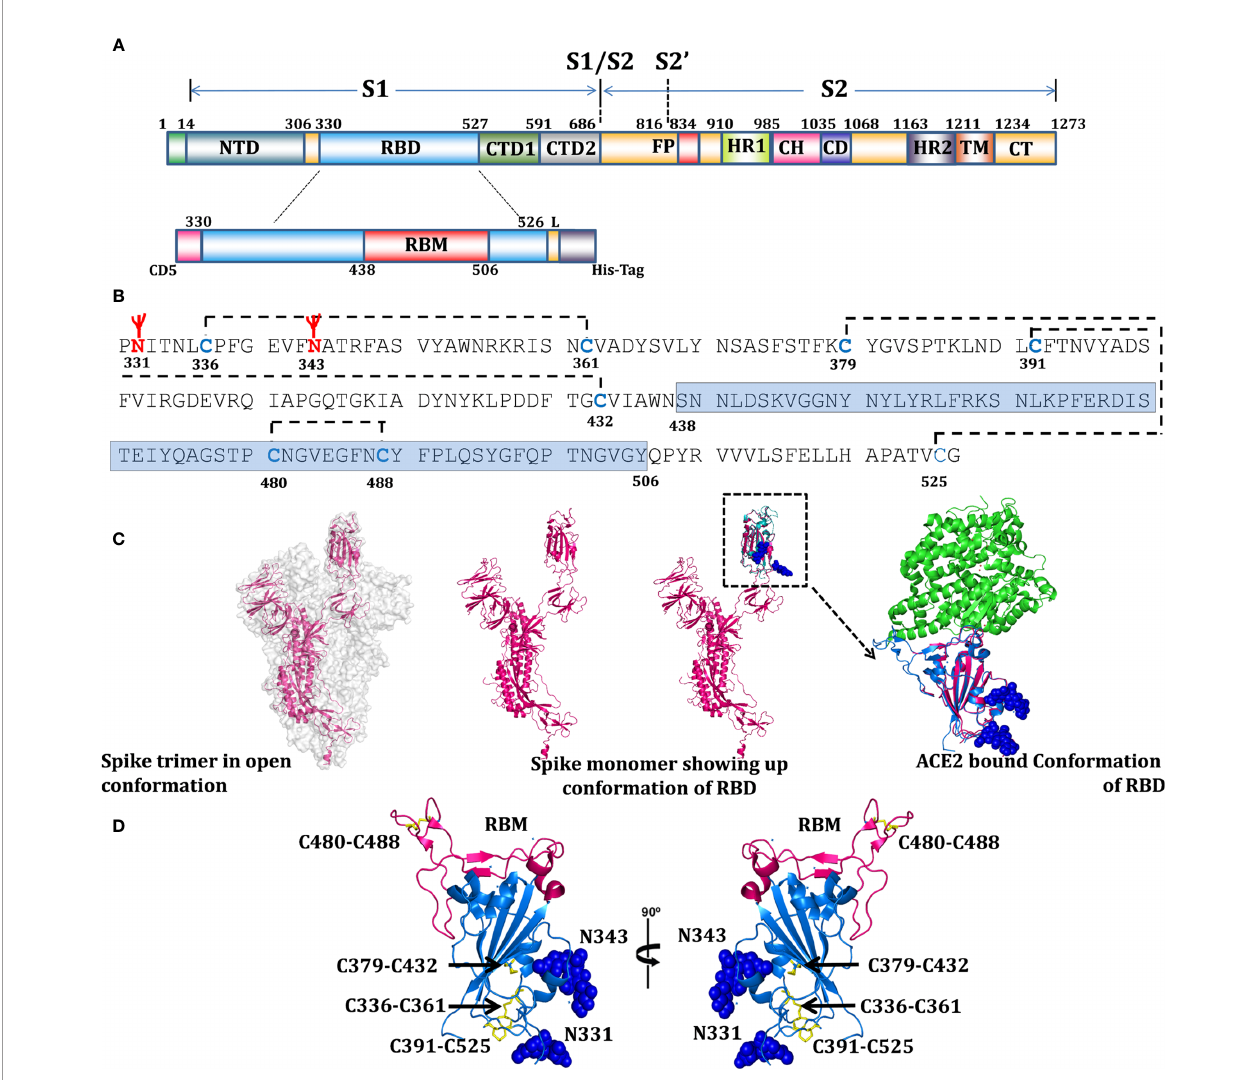
FIGURE 1 | Domain organization of SARS-CoV-2, RBD expression construct, and overall structural topology. (A) The schematic presentation of domain organization for the SARS-CoV-2 spike protein, differentially colored boxes represent domain boundaries; NTD (N-terminal domain), RBD (receptor binding domain), CTD1 and 2 (C-terminal domain 1 and 2), FP (fusion peptide), HR1 (heptad repeat 1), CH (central helix), CD (connector domain), HR2 (heptad repeat 2), TM (transmembrane domain), and CT (C-terminal domain) (30). The schematic representation of RBD; with N-terminal CD5 secretary sequences, coding sequences (330-526), RBM (receptor binding motif), 4 amino acid linkers, and 6x histidine tags. (B) Analysis of RBD coding sequences showing probable glycosylation sites at N331 and N343, cysteine residues - disul fi de bonding network and sequences coding for RBM. (C) Surface representation of spike trimer in open conformation (6VYB) (31) with one monomeric subunit shown in the cartoon presentation to represent the overall organization of a monomer in the trimeric spike structure. One monomer of the trimer superimposed with RBD structure (6VW1) (32) and inset showing RBD in ACE2-bound conformation, showing the potential glycan in sphere representations. Residues 330-334 represented through modeled and superimposed structure (pink), showing the probable position of glycan at N331. (D) Overall structure of RBD in two orientations, RBD ’ s (blue), RBM shown in light pink color, cysteine residue forming disul fi de bonds drawn as sticks and shown in yellow color, and two glycans are shown with sphere